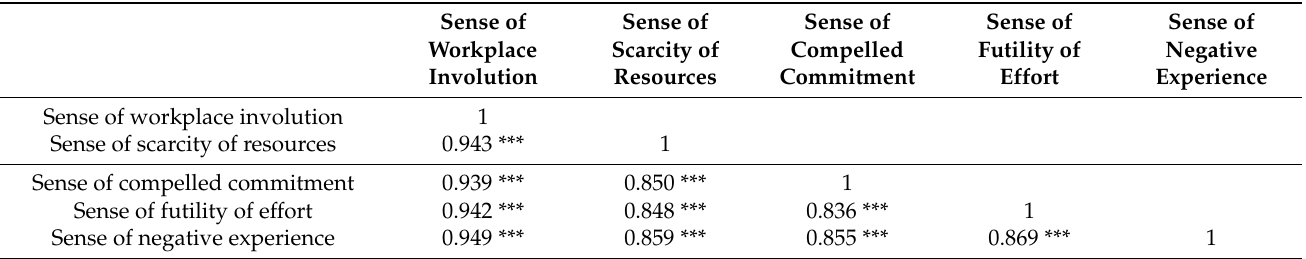
Table 5. Construct validity of the sense of workplace involution questionnaire for newly recruited